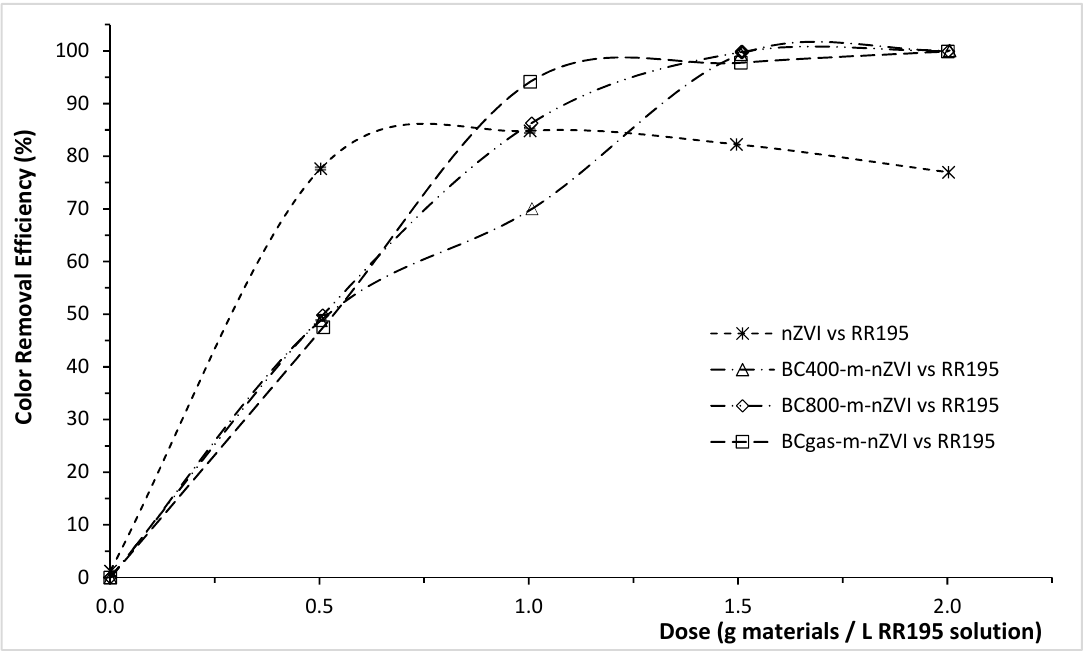
Figure 5. Color removal efficiency of the materials of nano zero valent iron (nZVI), magnetic-nZVI